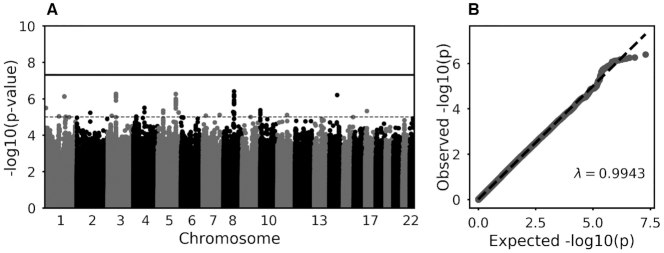
Manhattan (A) and QQ plot (B) of GWAS of gluten-free diet with age and sex as covariates. The solid line indicates genome-wide significance; the dashed line indicates suggestive significance. GWAS, genome-wide association study.